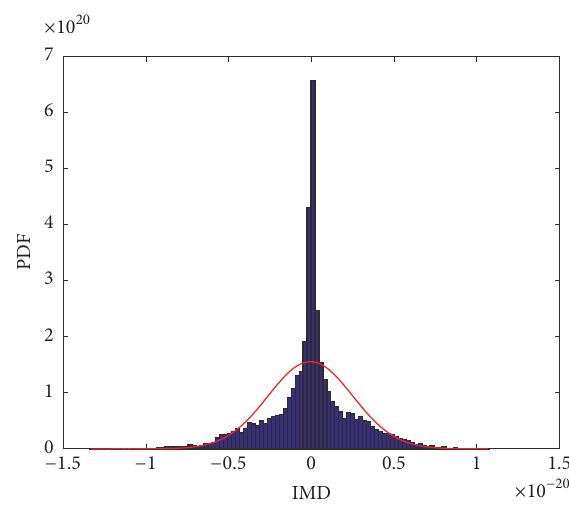
Figure 2: Third-order IMD term